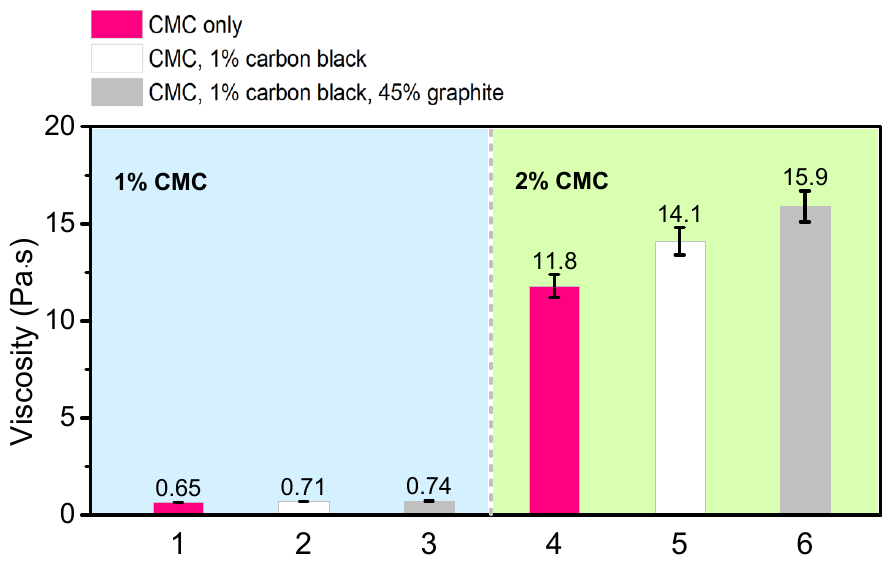
Figure 4. Viscosities of various slurry compositions.